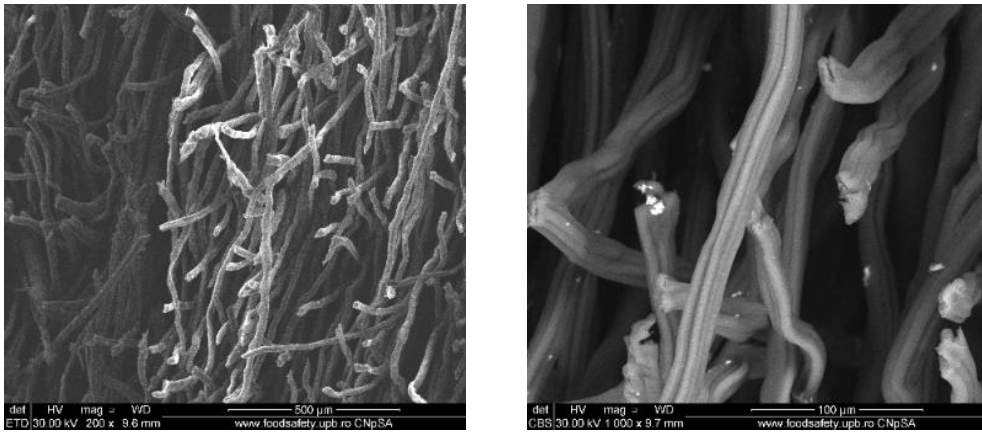
Figure 5. SEM images of wound dressings with silver nanoparticles, sodium alginate and mandarin oil. Left: global image, and right: detailed image.